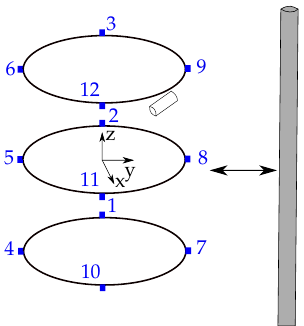
Figure 9. Iron cylinder in the proximity of the sensor array. The cylinder is z -orientated, whereas the displacement of the cylinder is in the y